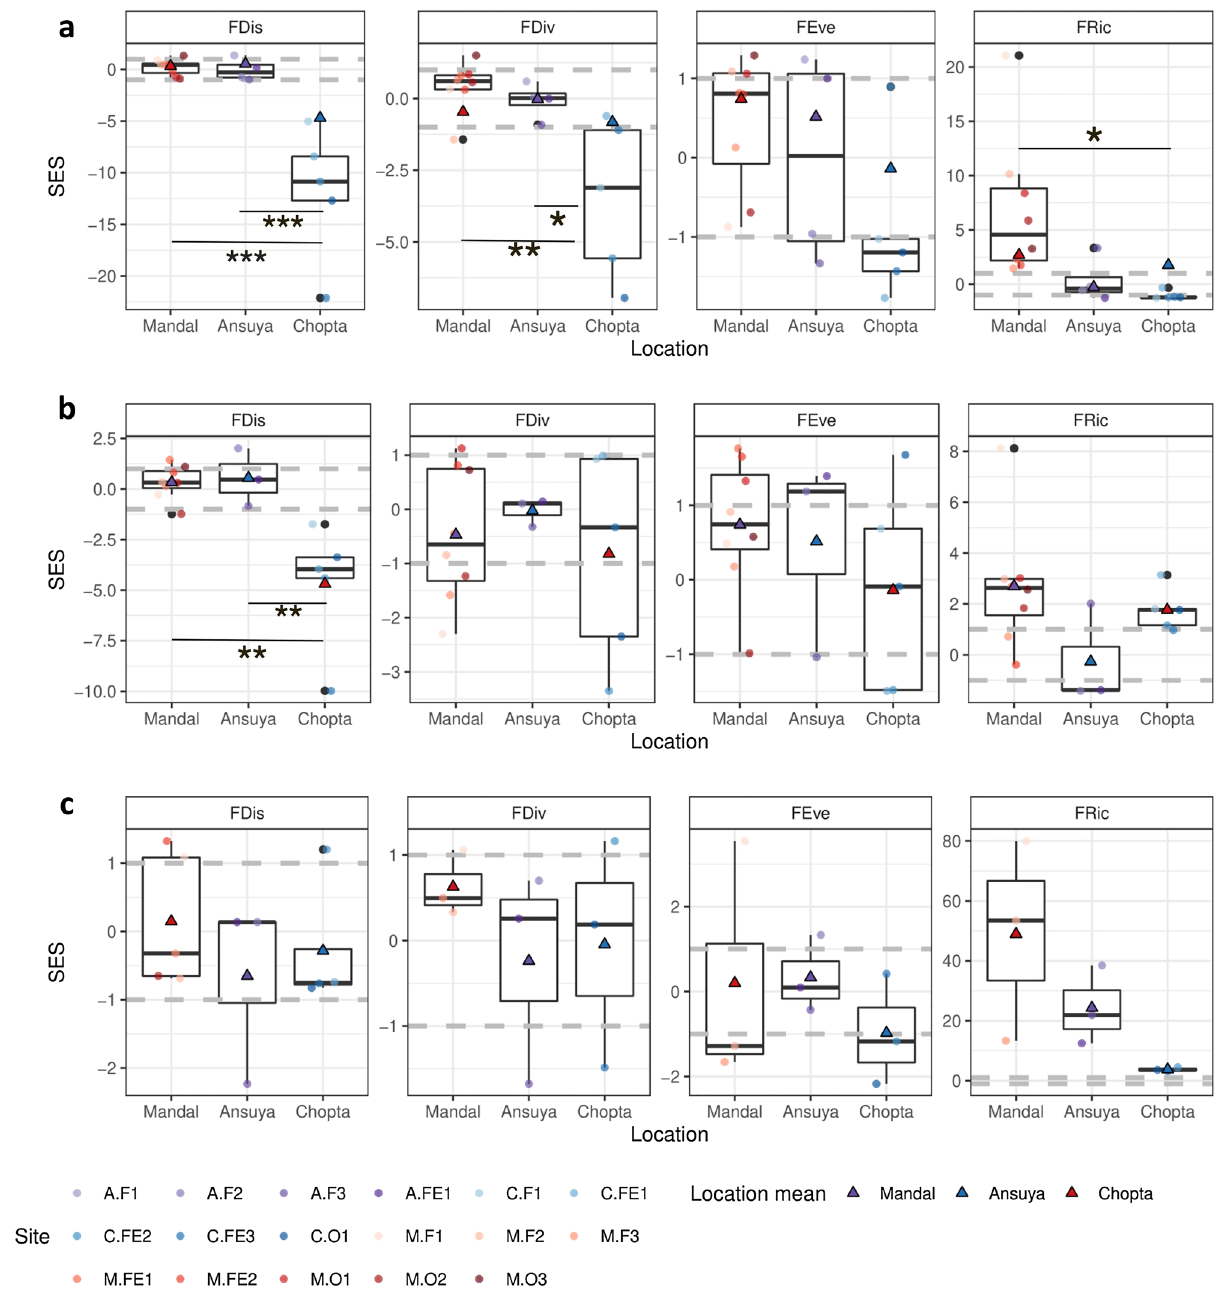
Figure 4. SES values of different elevational communities for corresponding FD indices obtained from constrained randomizations with 999 iterations; measured using ( a ) acoustic detections as relative abundance for all species/sonotypes, ( b ) acoustic detections as relative abundance excluding rhinolophid bats, and ( c ) mistnet captures as relative abundance for all species/sonotypes. |SES|= 1 and above are significantly different from the null model (for more details please see “Methods” section). Sampling points are denoted by dots and mean FD values by triangles within the boxplots. Lines connecting different elevations and *represent elevations with significantly different means as assessed from Tukey’s HSD test. *p < 0.05, **p < 0.01, ***p <